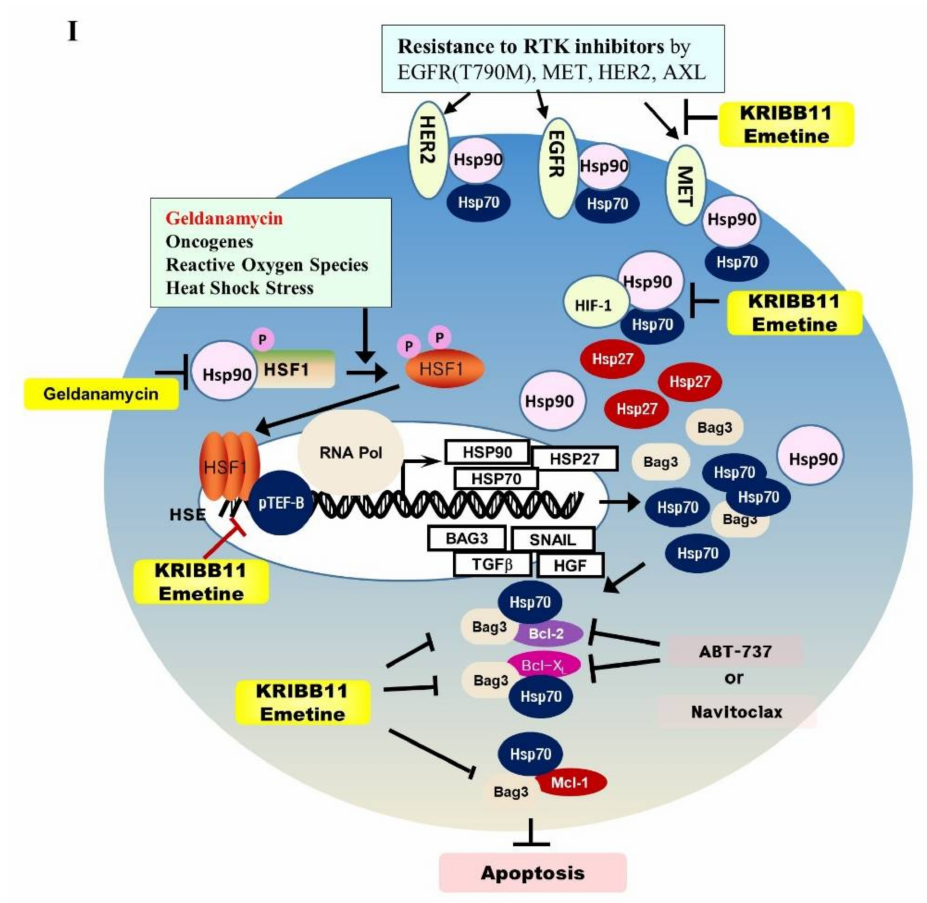
Figure 6. Emetine inhibits HSF1 activity and growth of PC9-ErlR cells in xenograft models. ( A ) The cephaeline and emetine structures are shown. ( B ) HCT116 cells were transfected with the p(HSE)4- TA-Luc reporter plasmid and treated with or without heat in the presence of different concentrations (10–500 nM) of cephaeline and emetine. Reporter assay was performed as described in Materials and Methods. ( C ) Cephaeline and emetine inhibited heat-induced expression of HSP70, BAG3, and HSP27 in HCT-116 cells. HCT-116 cells were treated with the indicated concentrations of cephaeline and emetine for 30 min, exposed to heat shock at 42 ◦ C for 30 min, and then incubated for an additional 5 h at 37 ◦ C. Whole-cell lysates were analyzed by Western blotting using the indicated antibodies (the protein band intensity was normalized to the actin band intensity). ( D ) PC9-ErlR cells were treated with 0.1% DMSO or the indicated concentration of emetine for 12–72 h. Whole-cell lysates were subjected to Western blotting (the protein band intensity was normalized to the actin band intensity); ( E ) To evaluate the in vivo antitumor activity of emetine, PC9-ErlR cells were implanted subcutaneously into the right flank of nude mice. When the tumor volume reached 55 mm 3 (day 1), PBS or emetine (1 mg/kg) was injected intraperitoneally for 5 days. Beginning on day 7, emetine (10 mg/kg) was injected intraperitoneally for 5 days per week for 18 days. Mice were sacrificed on day 25. The results shown are from one assay using 12 mice (6 mice for each compound). Tumor volumes were estimated using the formula: length (mm) × width (mm) × height (mm)/2. Body weight was measured on each indicated day. ( F ) The final tumor weights were measured. ( G ) For each compound, lysates were prepared from tumor tissues of 6 mice, and whole cell lysates were analyzed by Western blotting using the indicated antibodies (the protein band intensity was normalized to the actin band intensity). ( H ) The relative abundance of EGFR, HSF1, HSP27, and MCL1 in tumors was quantified using the LAS-4000 mini. ( I ) The proposed mechanism is shown by which HSF1 inhibition overcomes multiple mechanisms of EGFR-TKI